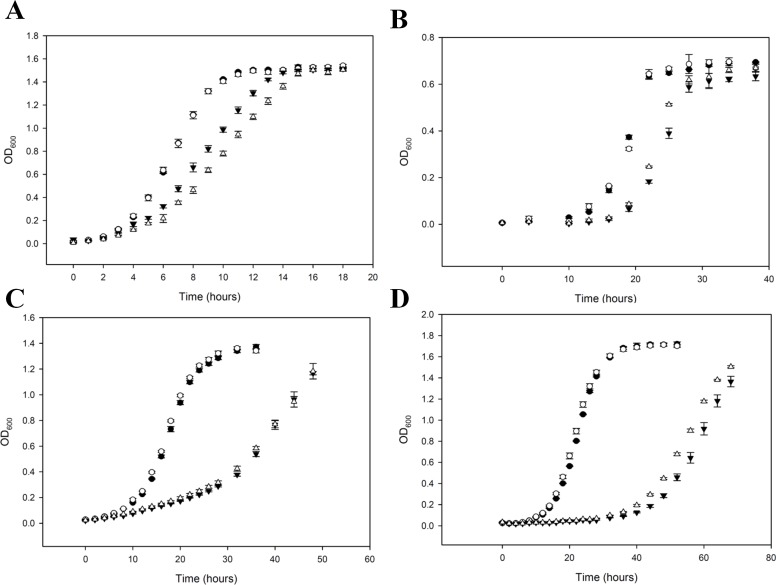
Growth of wild-type and mutant yeast under different conditions.The OD600 values were measured in a microplate (path length ~0.6 cm). Yeast were grown by flask culture in YP medium (1% yeast extract, 2% peptone) supplemented with 2% glucose (A, B), 3% glycerol (C); and 1% sodium acetate (D), under either normal (A, C, D) or hypoxic (B) conditions. Data are given as the average ± S.E. of three separate cultures. Symbols are: solid circles, wild-type; open circles, Δfpy1; solid triangles, Δflx1; open triangles, Δflx1/Δfpy1.